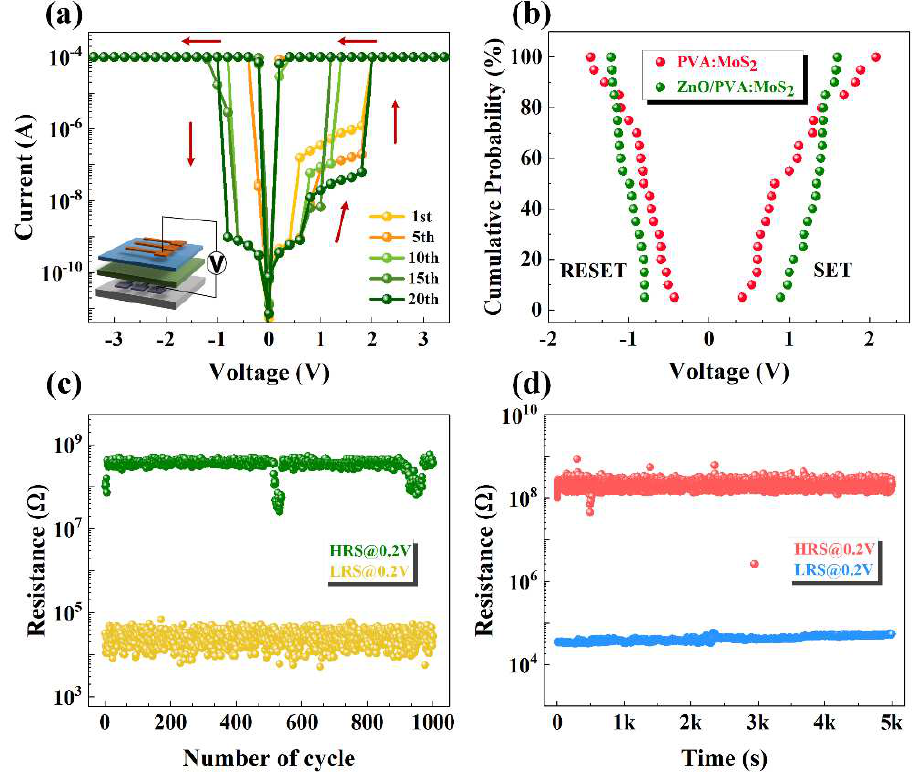
Figure 3. ( a ) The I − V characteristics of the Ag/ZnO/PVA: MoS 2 /ITO, PVA: MoS 2 = 4:1, insert: electrical circuit for the device. ( b ) Cumulative probability of SET/RESET voltages for Ag/PVA: MoS 2 /ITO and Ag/ZnO/PVA: MoS 2 /ITO, PVA: MoS 2 = 4:1. ( c ) DC sweep mode endurance cycles at read voltage 0.2 V, respectively. ( d ) Retention property in both LRS and HRS at read voltage 0.2 V. The cumulative probability distribution of V set and V reset voltages of the Ag/PVA: